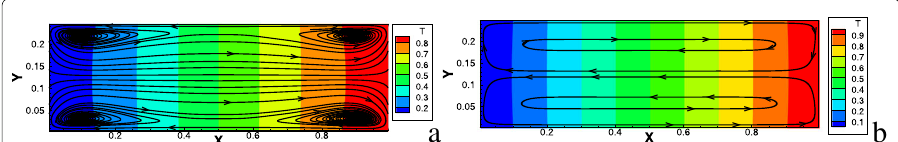
a b Fig. 13 The streamline and temperature distribution of the thermal creep flow. Left figure shows the solution with Knudsen number Kn = 10, and right figure shows the solution with Knudsen number Kn = 1.0 × 10 − 2